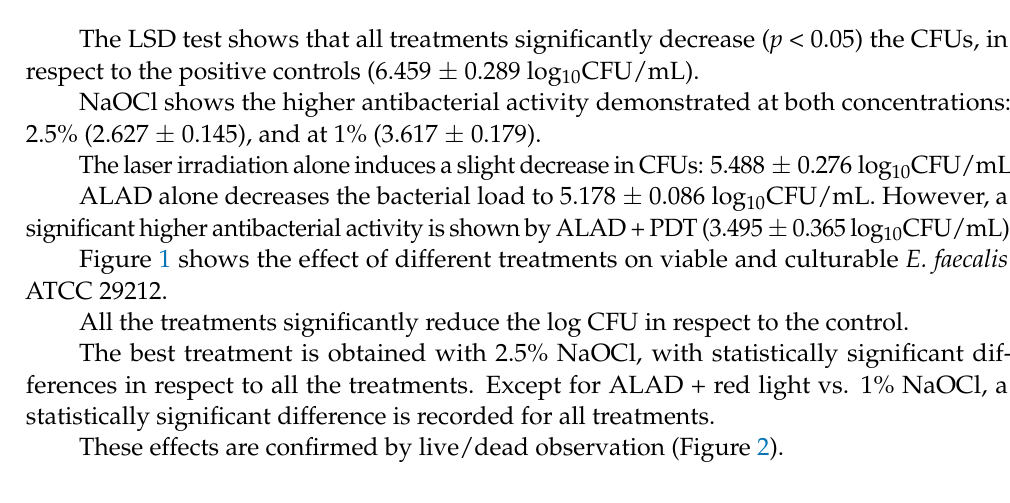
Figure 1. Cultivable E. faecalis cells count (log 10 CFU/mL) after several treatments. Data are presented as mean ± standard deviation (SD) and are expressed relative to CTRL (unexposed bacteria). LSD shows that, except for ALAD + red light vs. 1% NaOCl, a statistically significant difference is recorded for all treatments. * p <